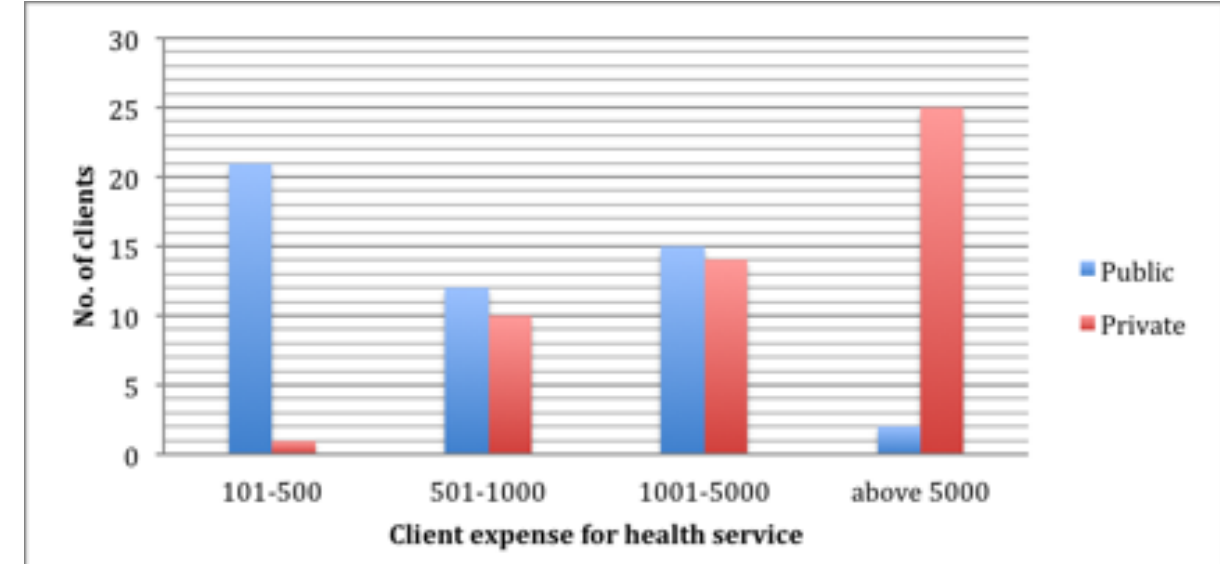
Figure 3. Comparison of private and public service expense cost by health